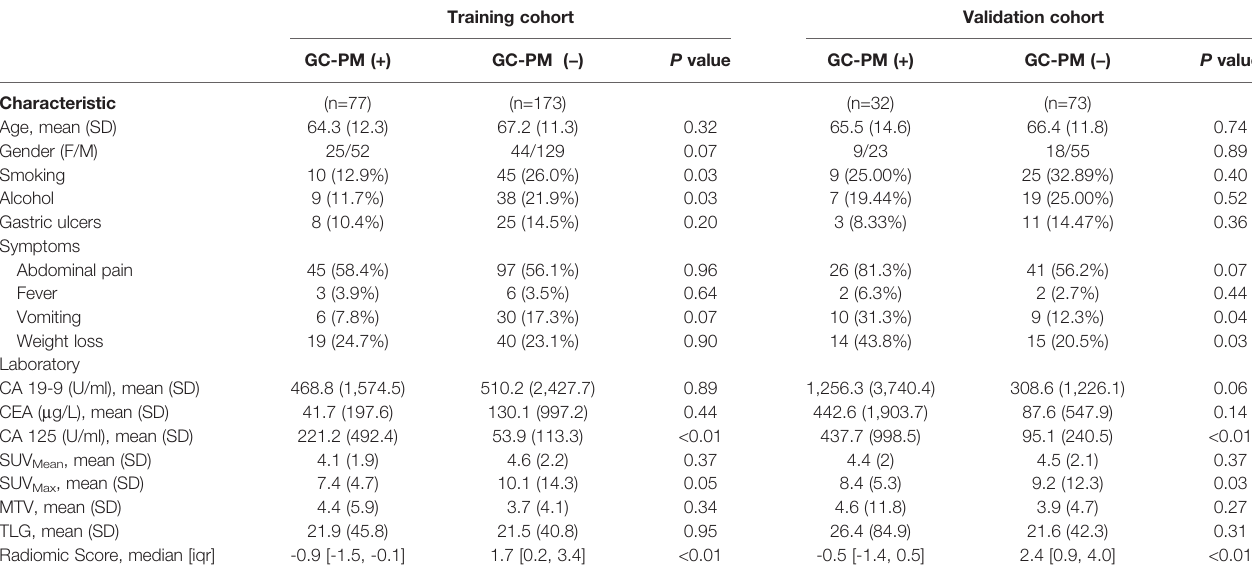
TABLE 1 | Demographic and clinical characteristics of the study population.